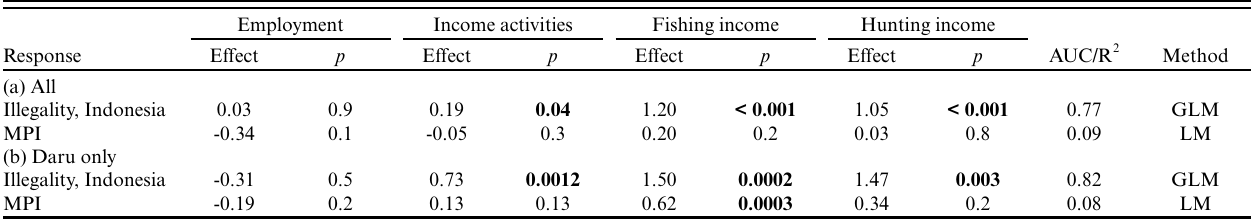
Table 3 . Linear regression models that tested the relationships between household-level illegality and multidimensional poverty index (MPI) against the explanatory variables of occupation (employment status, number of income-generating activities, fishing, or hunting providing income), divided into (a) all households and (b) Daru only. For each occupation explanatory variable, the table shows the parameter estimate and significance. The methods used are linear models (LM) and generalized (logistic) linear models (GLM). Goodness of fit measures are R² (LM) and area under the curve, or AUC (GLM). Bold indicates a statistically significant relationship (p ≤ 0.05).